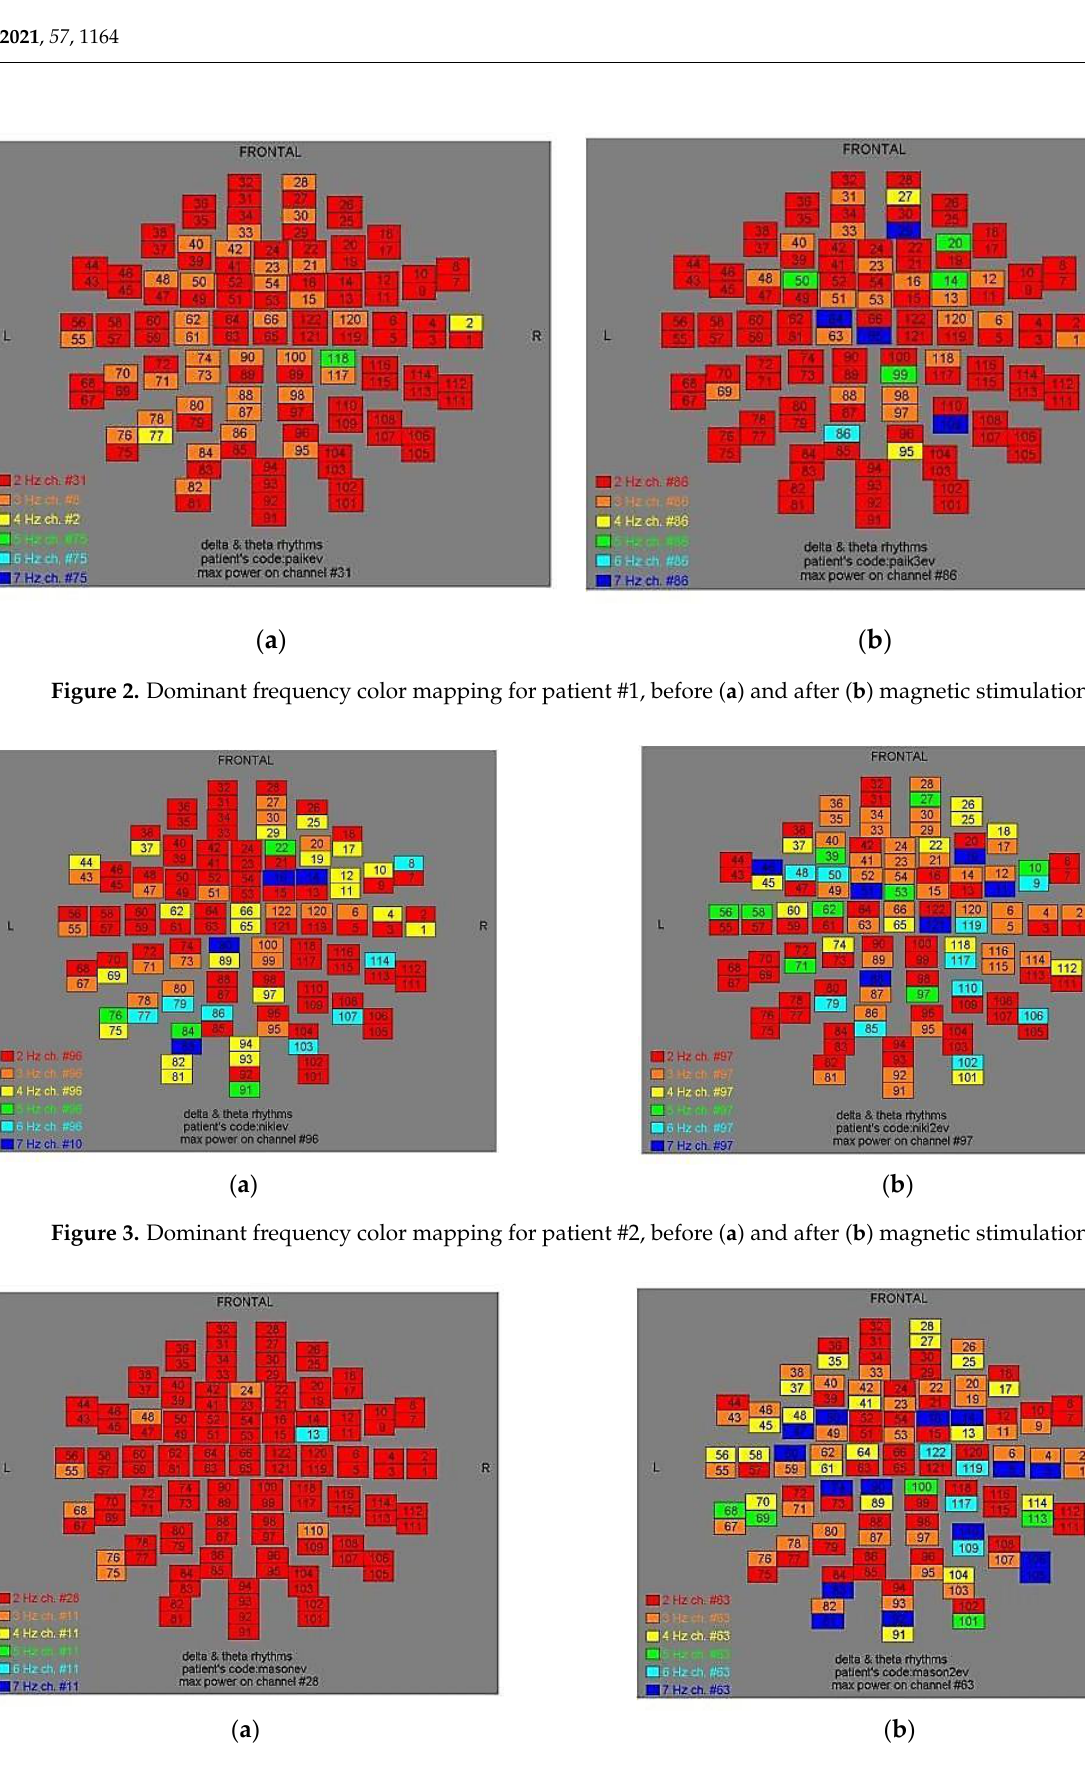
( a ) ( b ) Figure 5. Dominant frequency color mapping for patient #4, before ( a ) and after ( b ) magnetic stimulation.